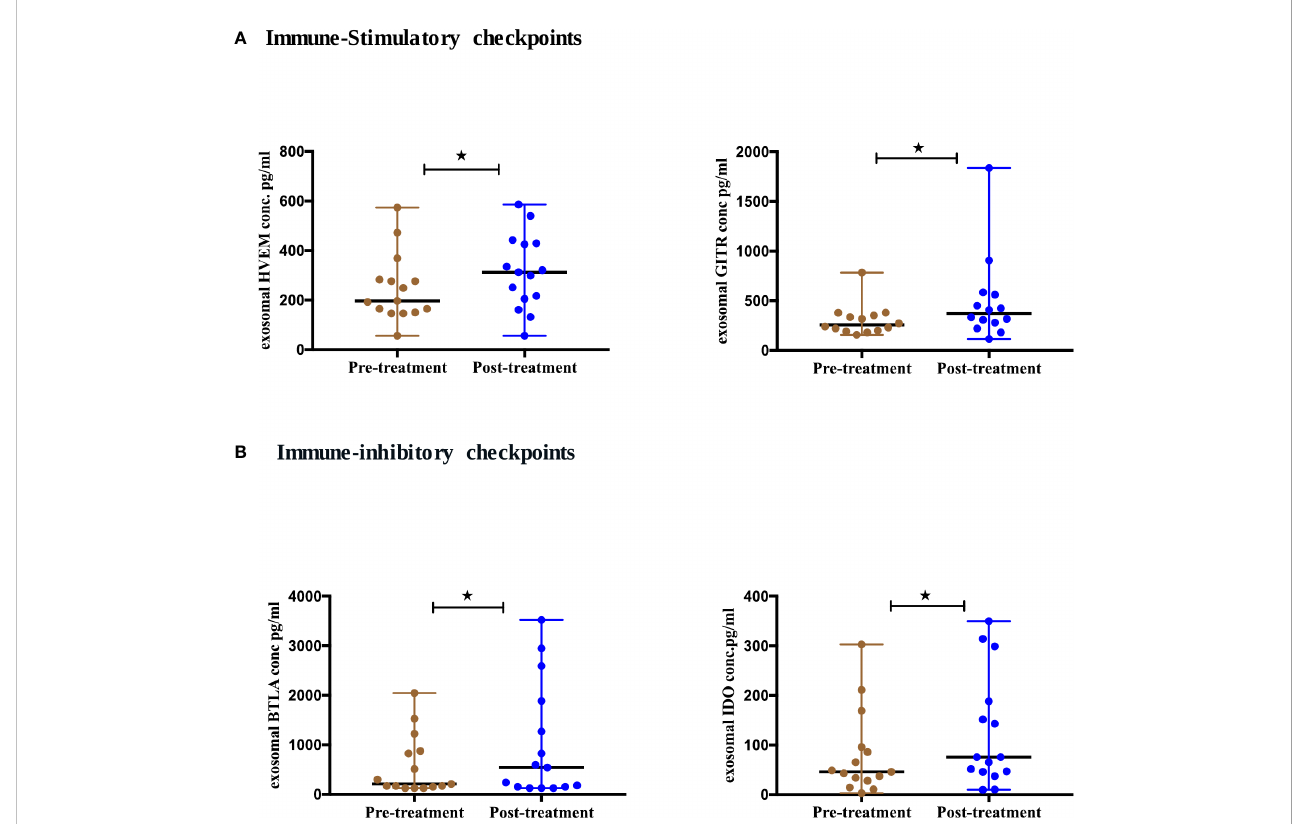
FIGURE 5 Differential expression of exosomal immune- checkpoints markers post-ICI therapy. (A) Immune-stimulatory checkpoints (B) Immune-inhibitory checkpoints from serum-derived exosomes of NSCLC patients (n=17) before and after anti-PD-1/PD-L1 checkpoint blockade immunotherapy. Two- tailed Wilcoxon matched-pairs signed rank test